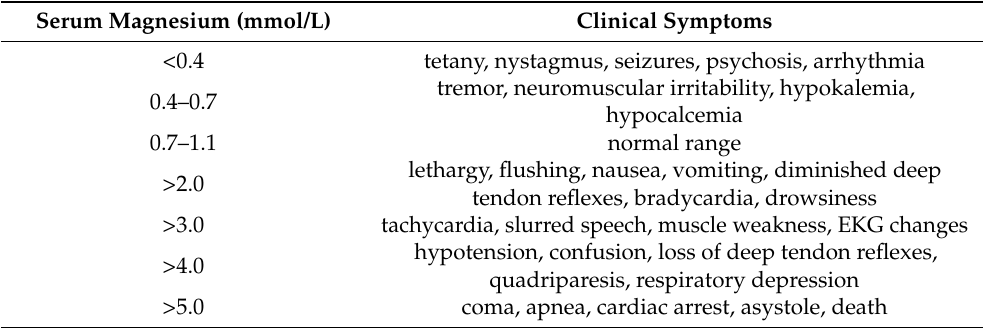
Table 5. Clinical symptoms of dysmagnesemias. The severity of the clinical signs depends on the serum magnesium concentration (conversion between mmol/L and mg/dL: multiply by